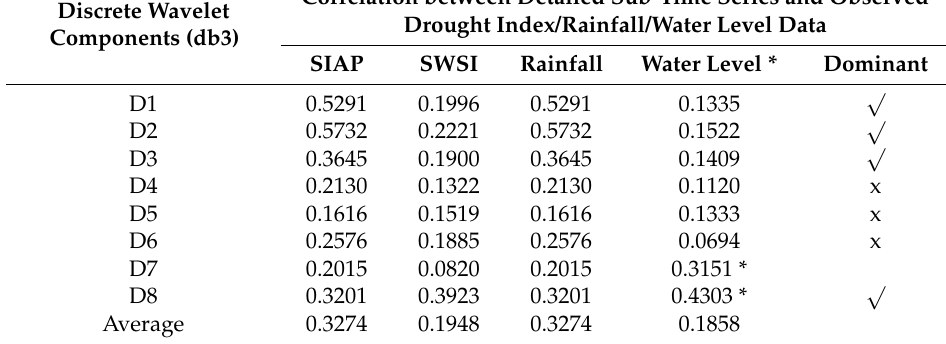
Table 8. The correlation coefficient between each sub-time series and original drought indices/raw input series.